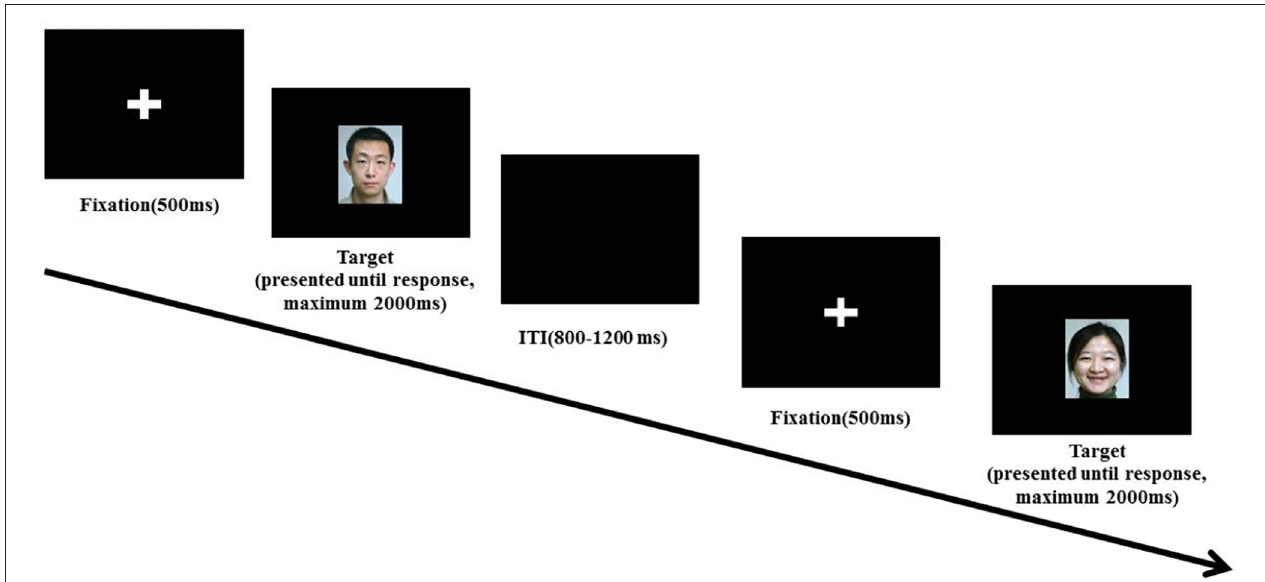
FIGURE 1 | Schematic illustration of the experimental